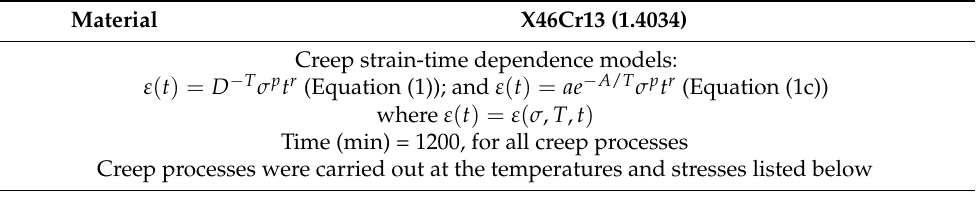
Table 3. Creep modeling